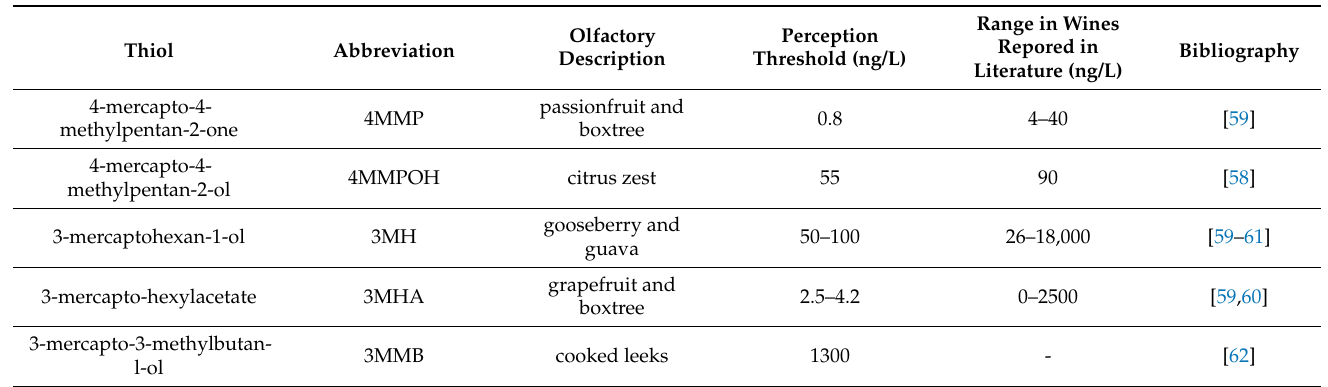
Table 1. Volatile thiols contributing to Sauvignon blanc’s